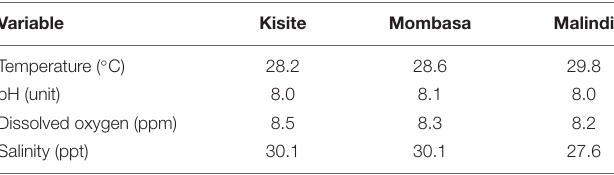
TABLE 1 | Measurements of physicochemical characteristics of the three coral reefs within the marine national parks at the time of sampling for metagenomic sequencing.